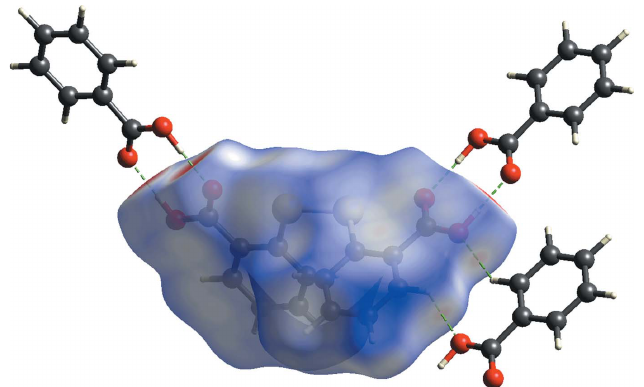
Figure 3 The Hirshfeld surface mapped with d norm for the DTBA molecule in (I) over the range (cid:3) 0.753 to 1.252 a.u., shown interacting with near- neighbour BA molecules connected through hydrogen bonds (green dashed lines). Figure 4 The electrostatic potential mapped over the Hirshfeld surface for ( a ) the DTBA molecule, ( b ) the BA molecule and ( c ) a BA molecule involved in a (cid:2) – (cid:2) stacking interaction with the ring of a DTBA molecule. The isovalue was scaled between (cid:3) 0.026 to 0.056 a.u. for all surfaces.